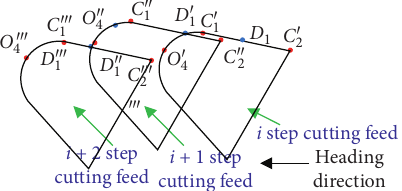
Figure 8: Cutting head cutting roadway forming